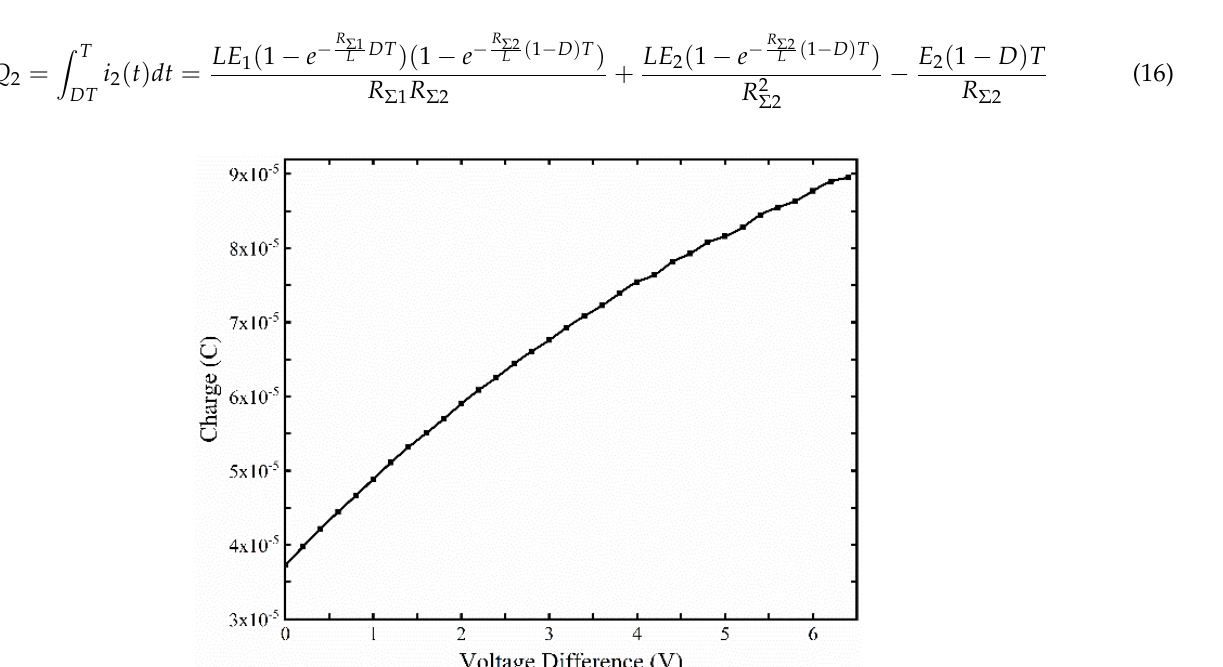
Figure 14. The amount of charge transferred to Cell2 at different voltage differences.